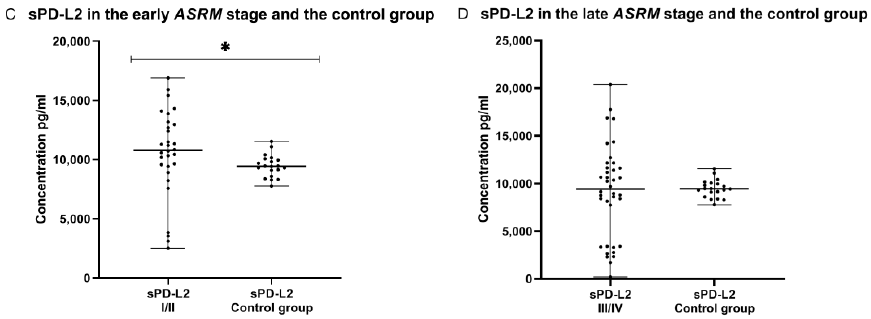
Figure 10. Levels of sPD-L1 and sPD-L2 in the plasma in early (I/II) and late (III/IV) ASRM stages of endometriosis and in the plasma of the control group ( A – D ) pg/mL. The median values with the following signs indicate statistically significant differences: * p < 0.05, *** p < 0.001.